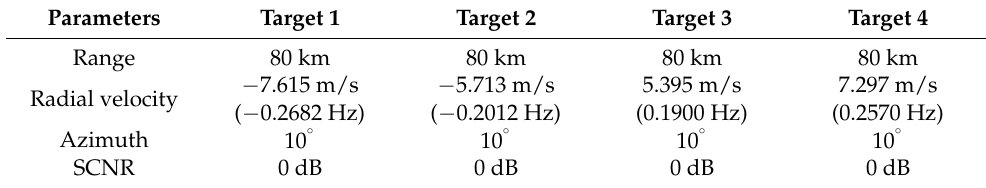
Table 2. Injected target